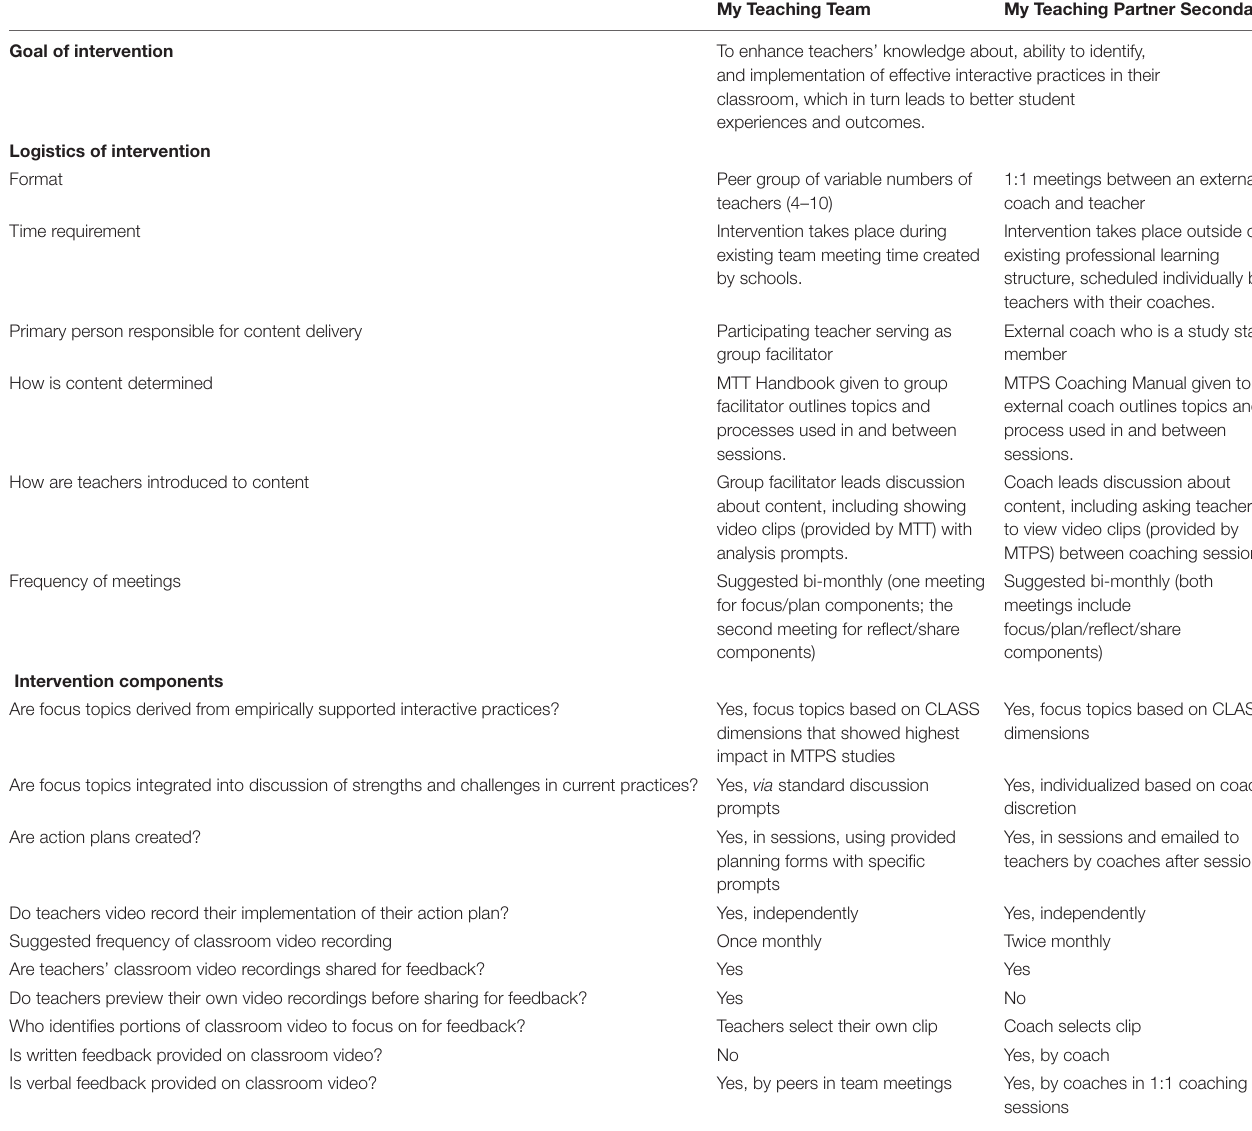
TABLE 1 | My Teaching Team compared with My Teaching